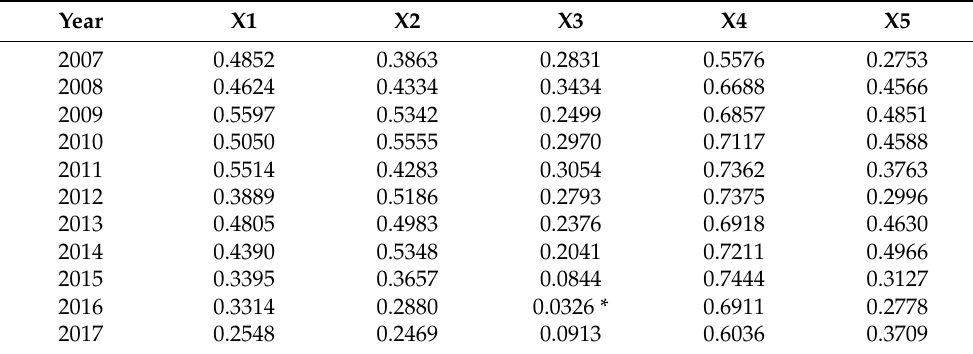
Table 5. Detection results of factors affecting the coupling coordination